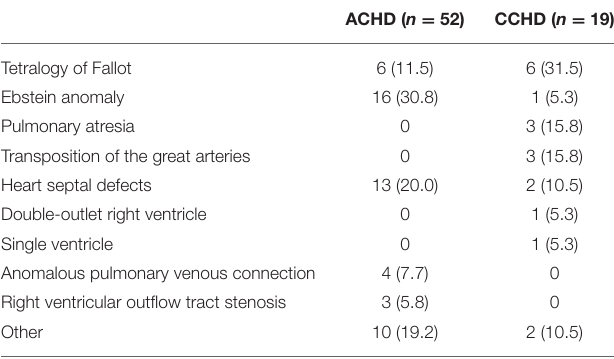
TABLE 2 | Distribution of main cardiac malformations of CHD patients. TABLE 3 | Comparison of RVD before and after cardiopulmonary bypass in CHD